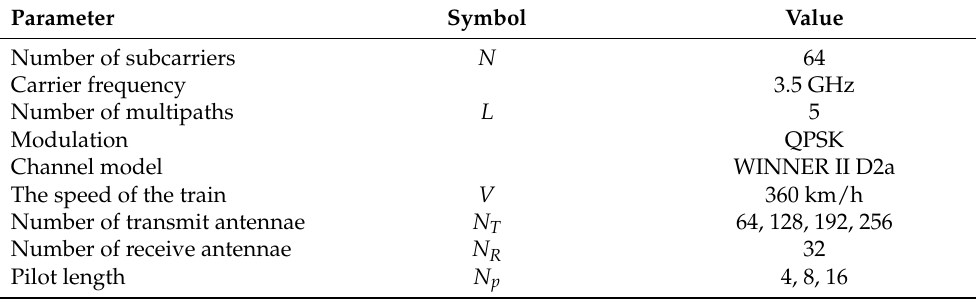
Table 1. Simulation